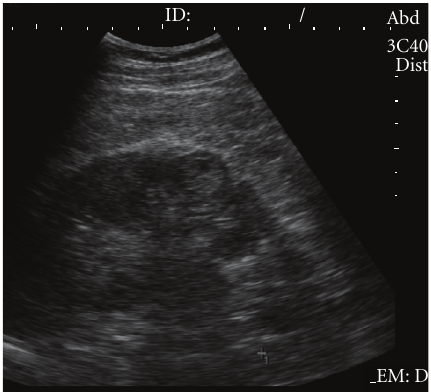
Figure 4: Well-defined hyperechoic small renal mass with hypoe- choic rim and intratumoral cystic area, confirmed with pathologic analysis as renal cell